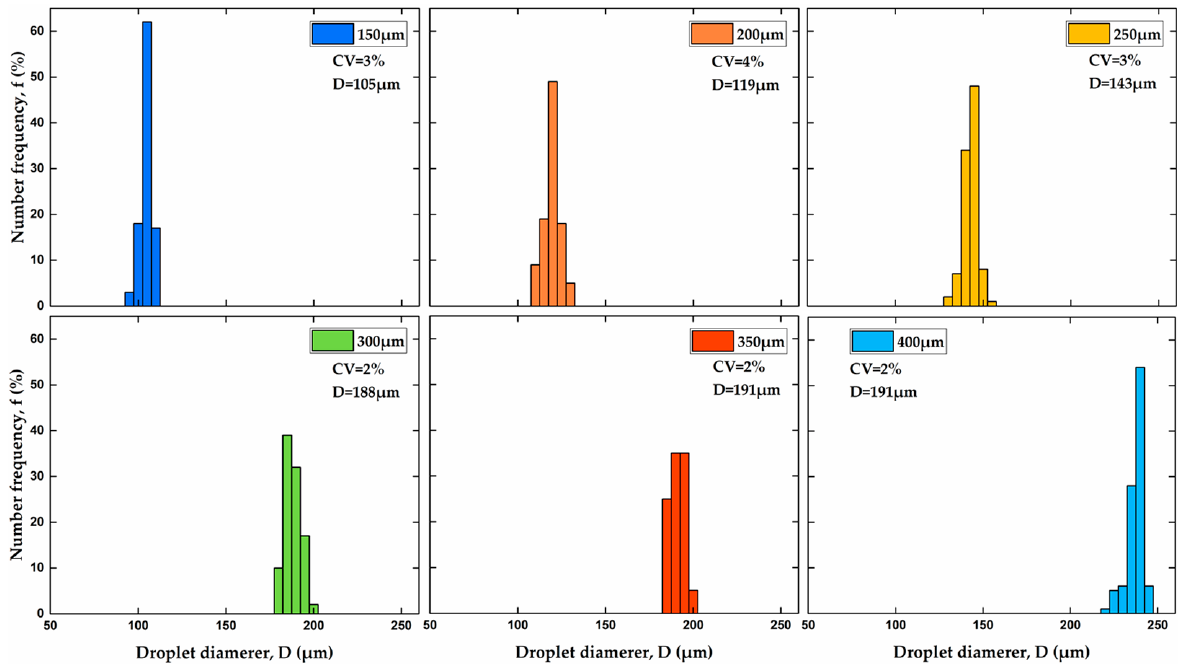
Figure 6. Size distribution of PEGDA particles produced using different orifice sizes shown in the legend of each graph. The coefficient of variation, CV and average particle diameter, D are shown in all graphs. The flow rate ratio, Q 1 / Q 2 was kept constant at 6.